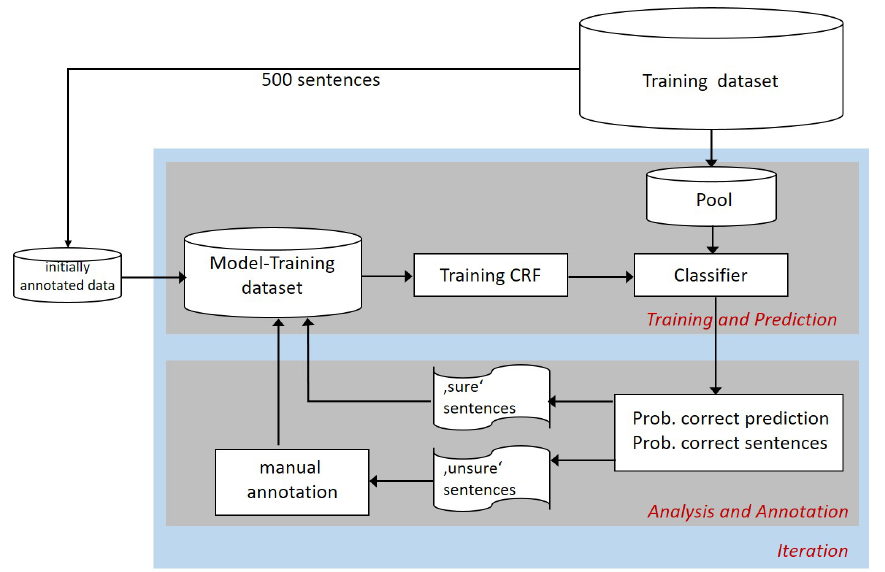
Figure 2. Schematic description of the sequence of steps composing the iterative procedure